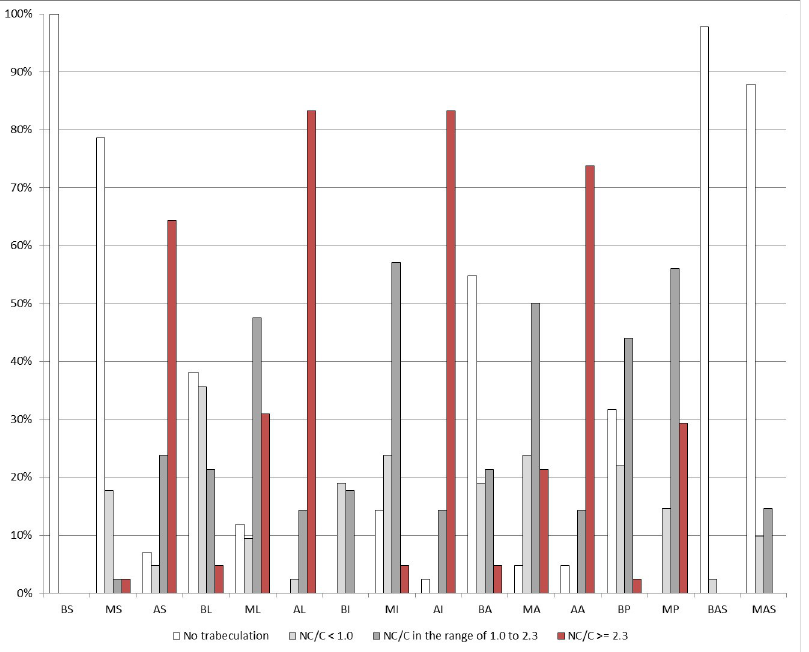
Fig 3. The graphical distribution of the left ventricular trabeculation in the left ventricular noncompaction group. The vertical axis presents the percentage of the left ventricular segments with the extent of trabeculation described by the noncompacted to compacted layer thickness ratio (NC/C) localized on the horizontal axis. The left ventricular segments description: basal, middle, and apical septal segments (BS, MS, AS), lateral segments (BL, ML, AL), inferior segments (BI, MI, AI), anterior segments (BA, MA, AA), basal and middle posterior segments (BP, MP) and anteroseptal segments (BAS, MAS).